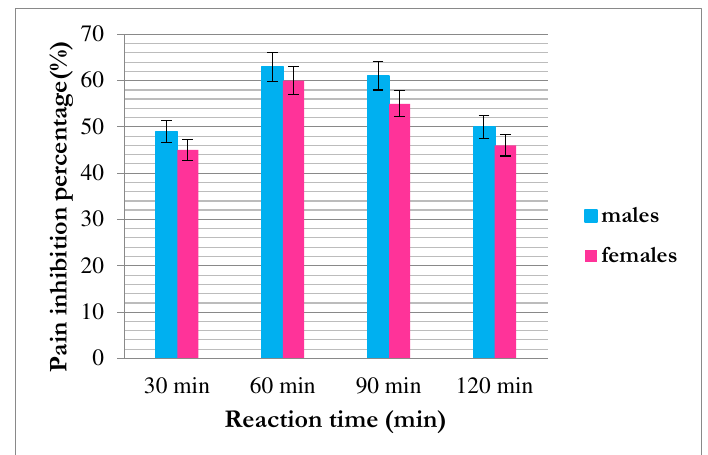
Figure 1. The percentage of pain inhibition according to mice gender after administration of the aqueous extract at 300 mg kg -1